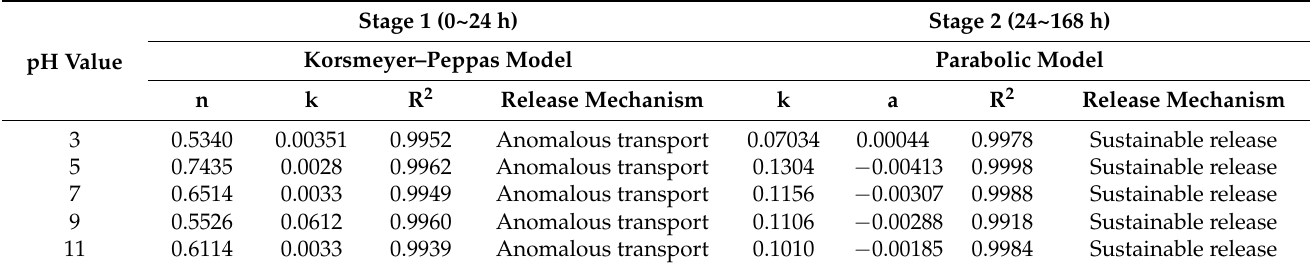
Figure 6. Plots of the two kinetic models: ( a ) Korsmeyer–Peppas model and ( b ) Parabolic model for the release of OIM from OIM@PAM in the two stages. Table 1. The fitting parameter and mechanisms of OIM from OIM@PAM in different pH